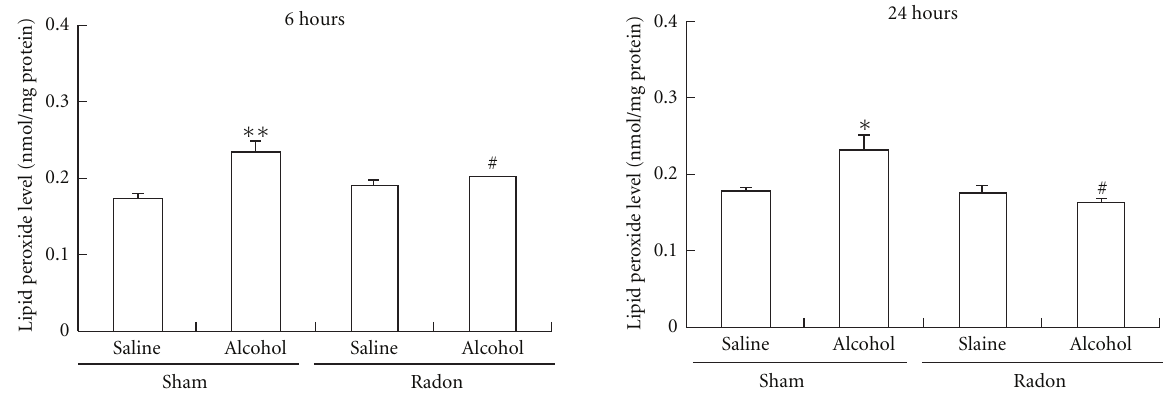
Figure 4: E ff ects of radon inhalation on lipid peroxide level in liver after alcohol administration. Each value indicates the mean ± SEM. The number of mice per experimental point is 5-6. ∗ P < 0 . 05, ∗∗ P < 0 . 01 versus each saline-administrated mice, # P < 0 . 05 versus sham inhaled and alcohol-administrated